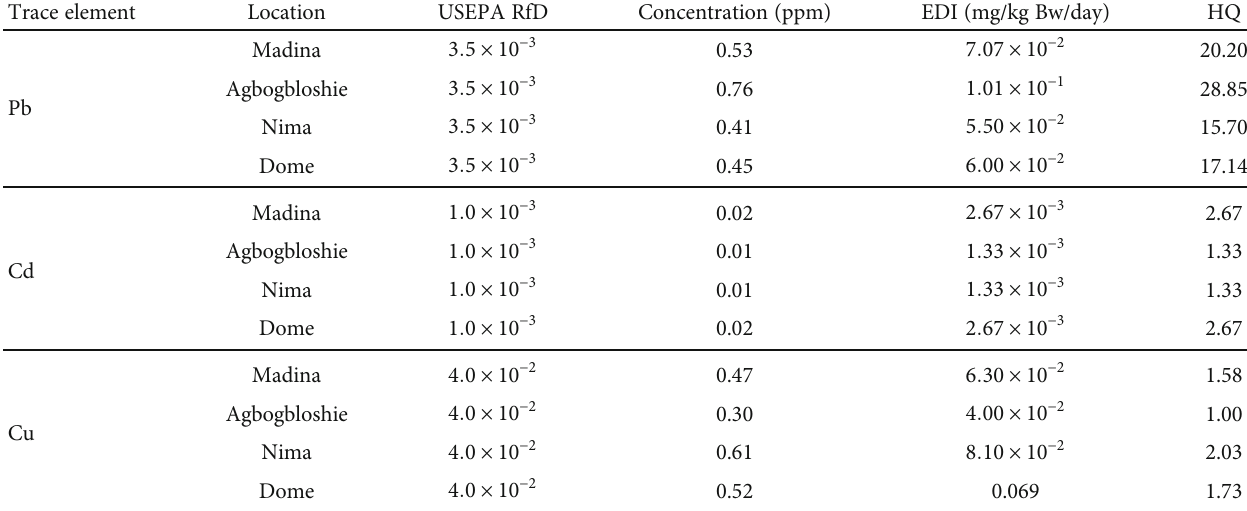
Table 3: The estimated daily intake (EDI) and Hazard Quotient (H.Q) of toxic metals in egusi from the various locations. Trace